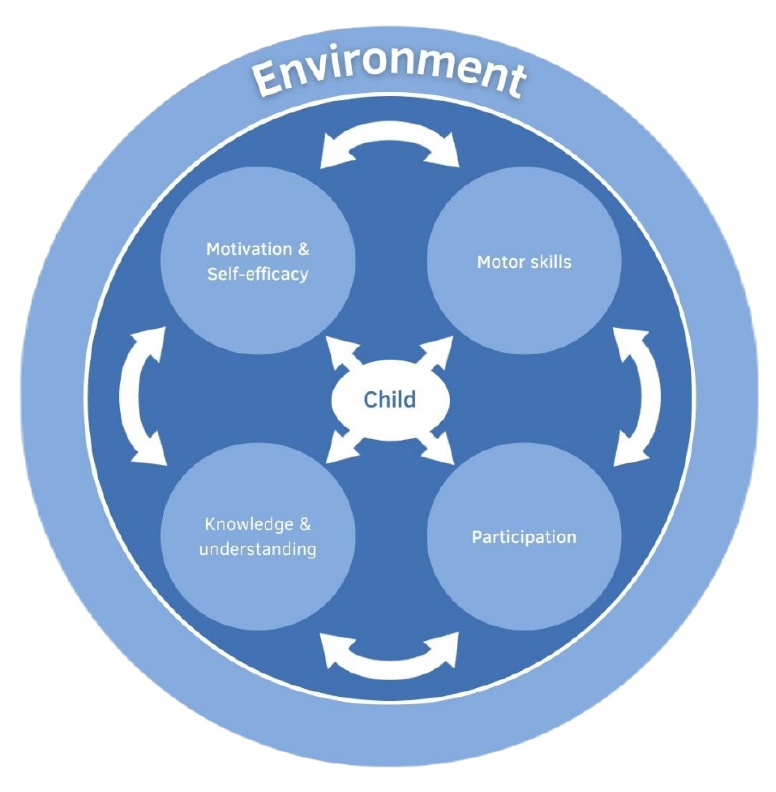
Figure 1. Theoretical model as a basis for the assessment tool [30].